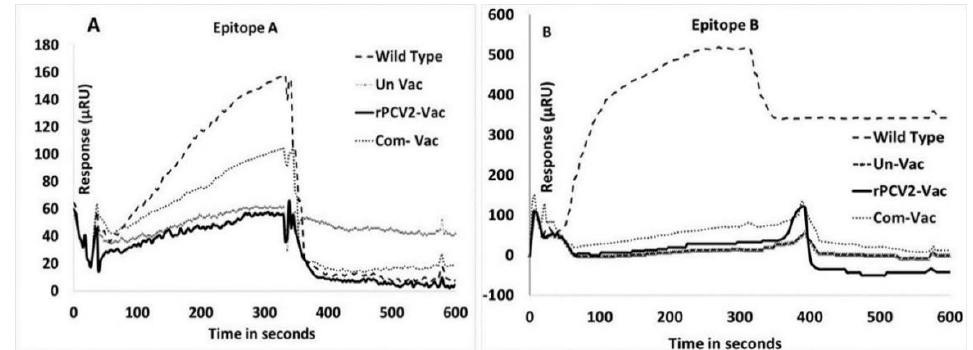
Figure 5. Antibody responses to the mutated epitopes: Loss of immunodominant effects due to mutation of epitopes ( A ) and ( B ) as assessed qualitatively by surface plasmon resonance. 20 µM of purified IgG was tested for all experimental antisera. X axis—Time in seconds, Y axis—Response measured in µRU (µ response units). ( A ). Responses to a peptide encoding the wildtype epitope ( A , B ). Responses to a peptide encoding wildtype epitope ( B ). Slashed line-anti-serum to the wildtype virus, dotted line: anti-serum to the commercial vaccine, solid line-anti-serum to the rPCV2-Vac, connected triangles: anti-serum from the unvaccinated group.